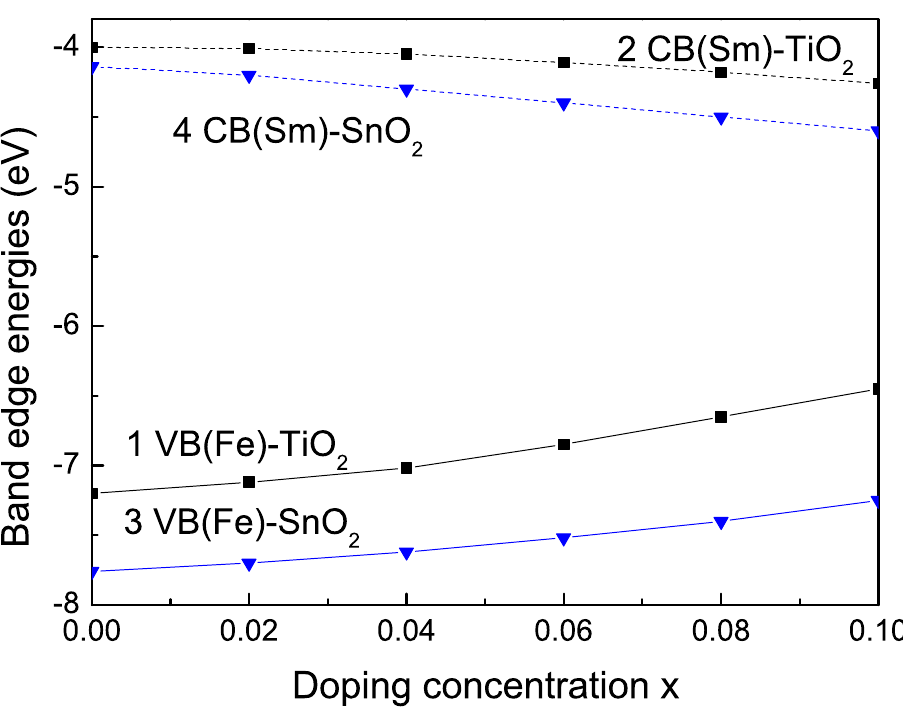
Figure 2. Dependence of the (1,3) VB edge energy of Fe-doped and (2,4) of the CB edge energy of Sm-doped bulk TiO 2 and SnO 2 , respectively, on the ion-doping concentration x